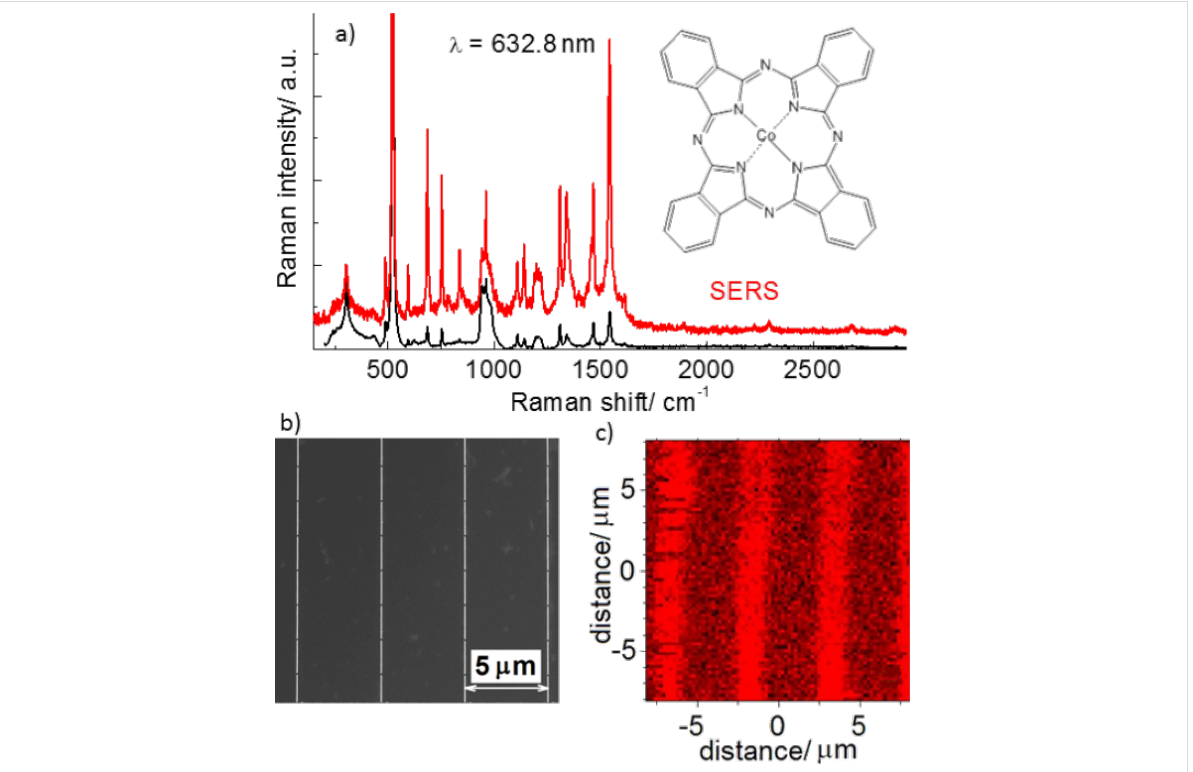
Figure 2: (a) Raman and SERS spectra of a cobalt phthalocyanine (CoPc) film with thickness of 3 nm deposited on a nanoantenna array. The chemi- cal structure of CoPc is shown in the inset. (b) SEM image of the nanoantenna array with antenna length of 1900 nm. (c) Raman mapping (100 × 100 pixels) of the C=N mode (1543 cm − 1 )